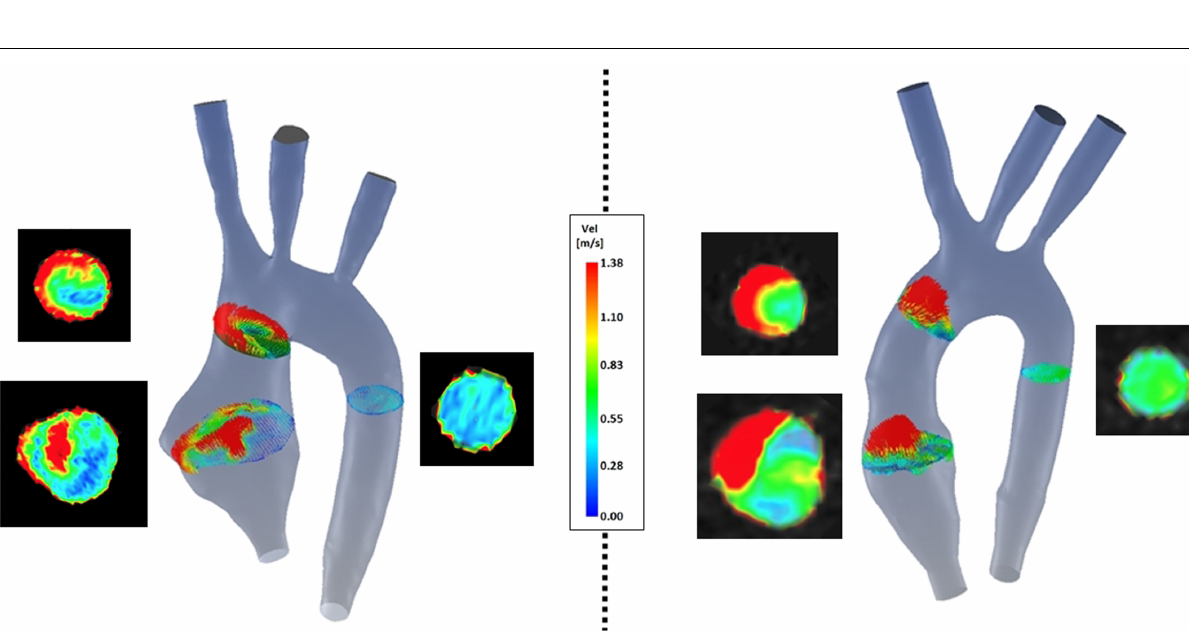
FIGURE 7 | Correlation and Bland Altman plots for flow measurements (CMR vs. CFD) at four locations in the TGA model .